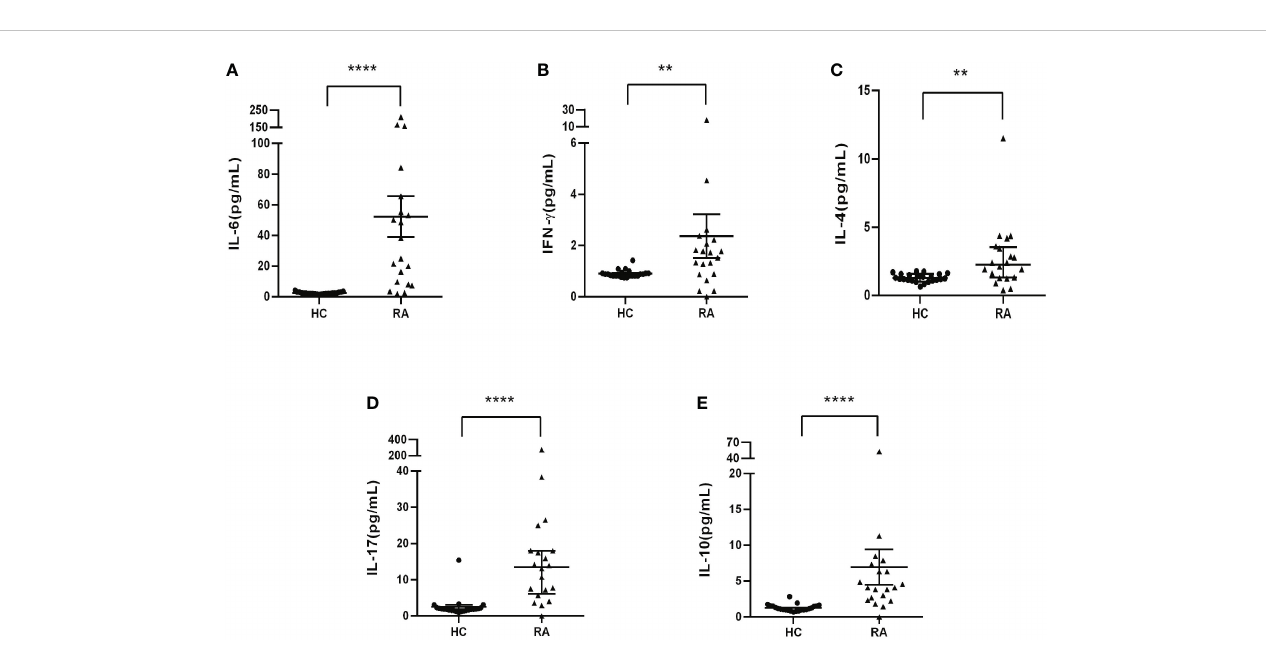
FIGURE 5 Serum levels of cytokines in RA patients and health controls by CBA. (A) Levels of IL-6. (B) Levels of INF- g . (C) Levels of IL-4. (D) Levels of IL-17. (E) Levels of IL-10. Each dot represents one individual and data are mean ± SD. **P < 0.001, ****P <